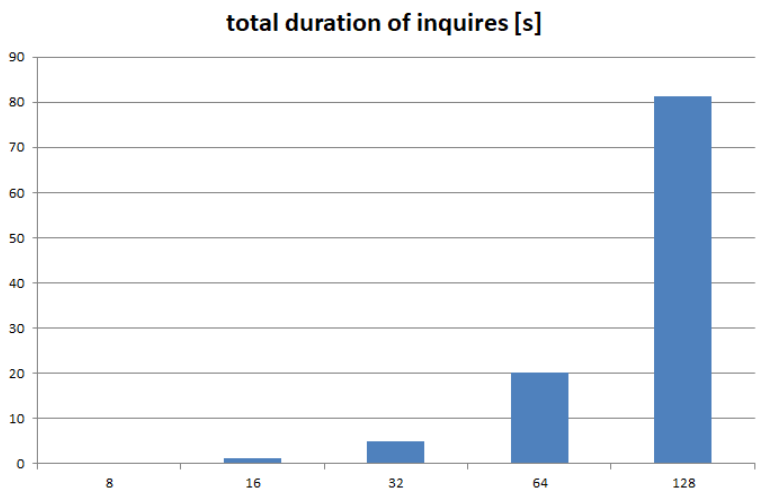
Figure 12. Evolution of the total duration of status requests as a function of the number of peers in the